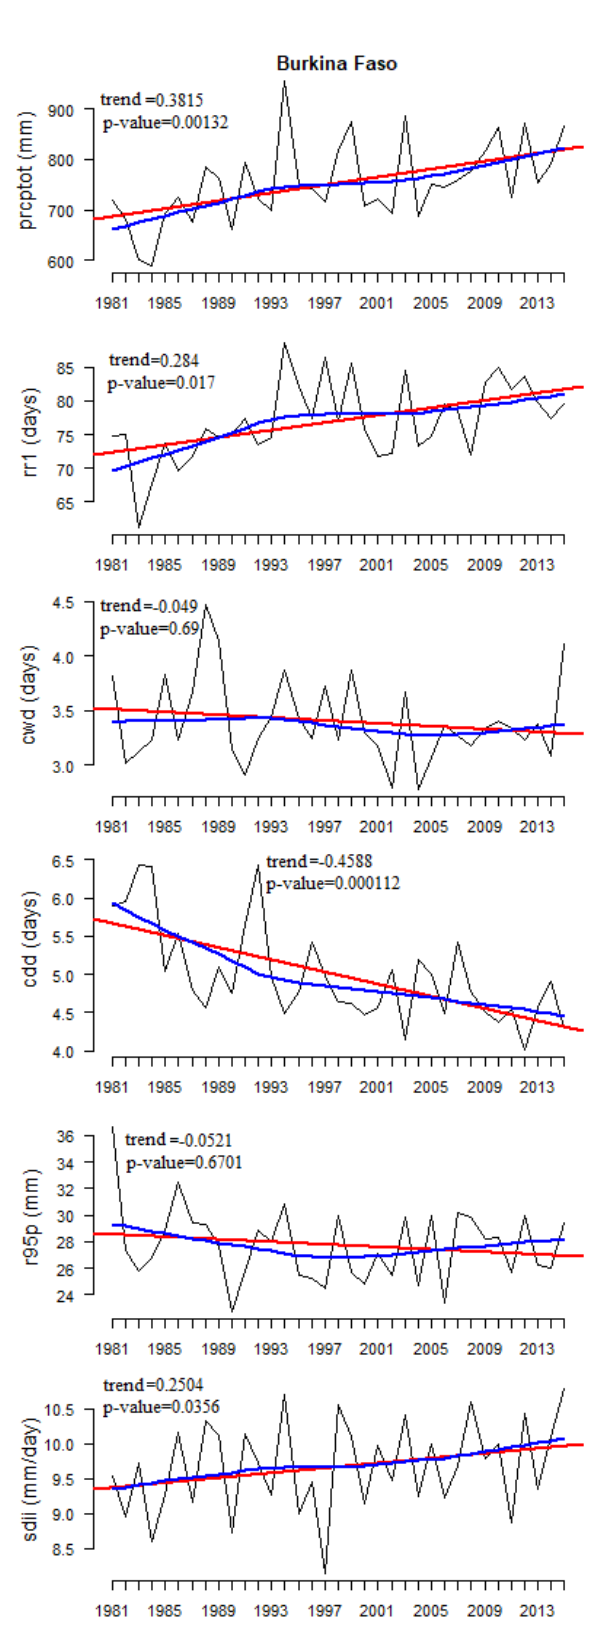
Figure 5. Time evolution of PRCPTOT (mm), RR1 (days), CWD (days), CDD (days), R95P (mm), and SDII (mm / day), averaged over Burkina Faso. The red line corresponds to the linear regression in the time series (1981–2015) and the blue curve corresponds to the best fit of the weighted least squares, shown as the best line with the minimal distance from the data.